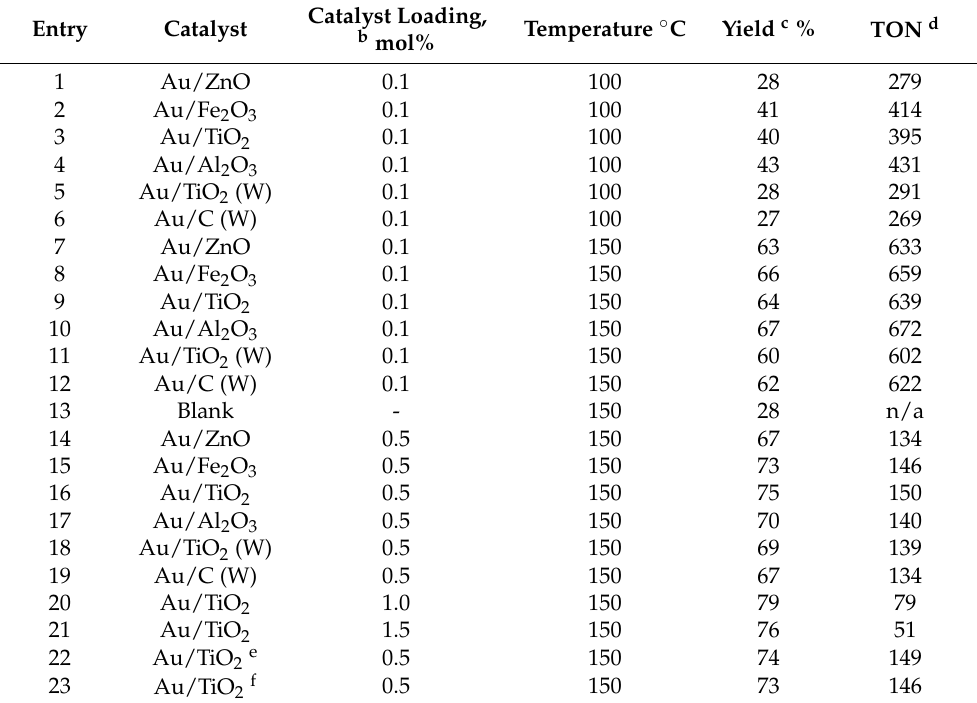
Table 3. Selected data for the microwave-assisted synthesis of 1-benzyl-4-phenyl-1 H -1,2,3-triazole catalyzed by Au nanoparticles on different metal oxide supports a .